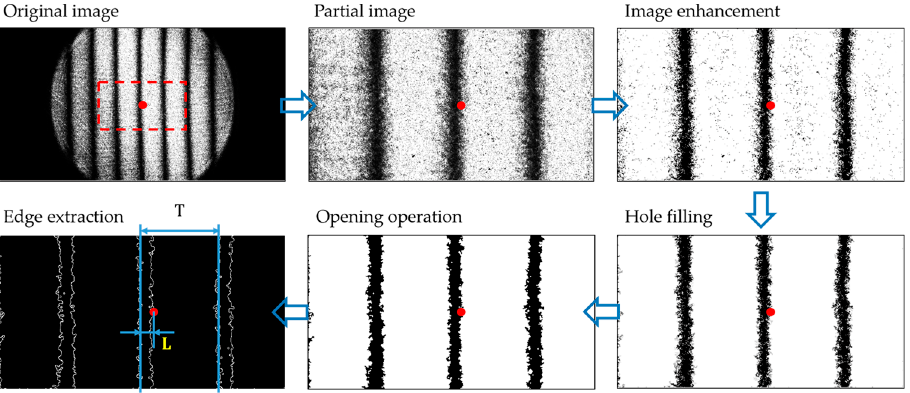
Figure 9. Edge extraction based on the image processing technique.